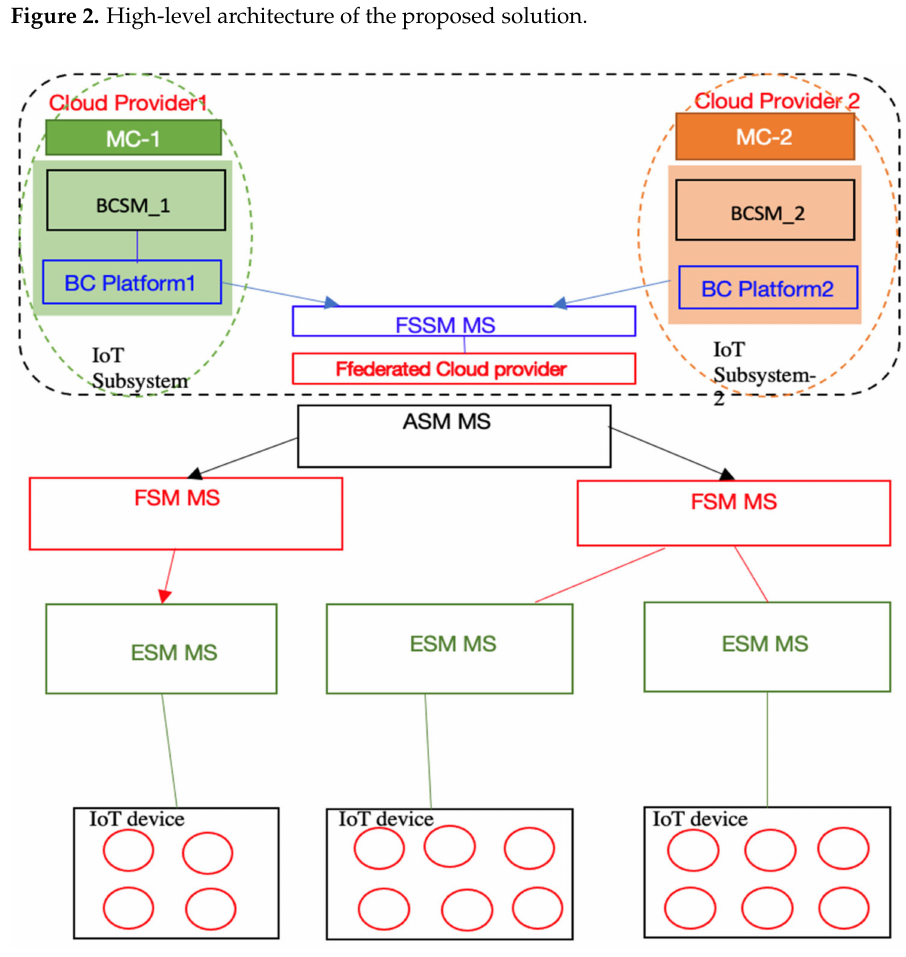
Figure 3. The architecture design of the proposed